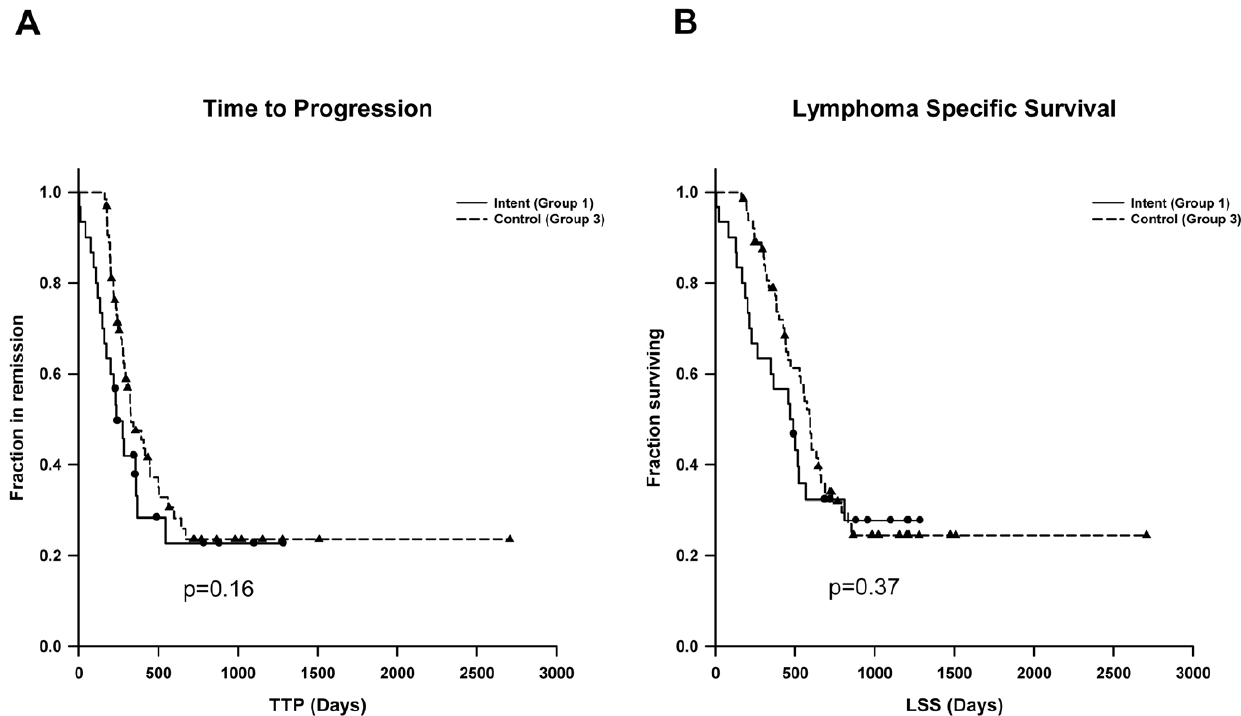
Figure 1. Kaplan Meier estimates comparing intent-to-treat Group 1 to unvaccinated control Group 3 for (A) time-to-progression (TTP) (p=0.16) and (B) lymphoma-specific survival (LSS) (p=0.37).